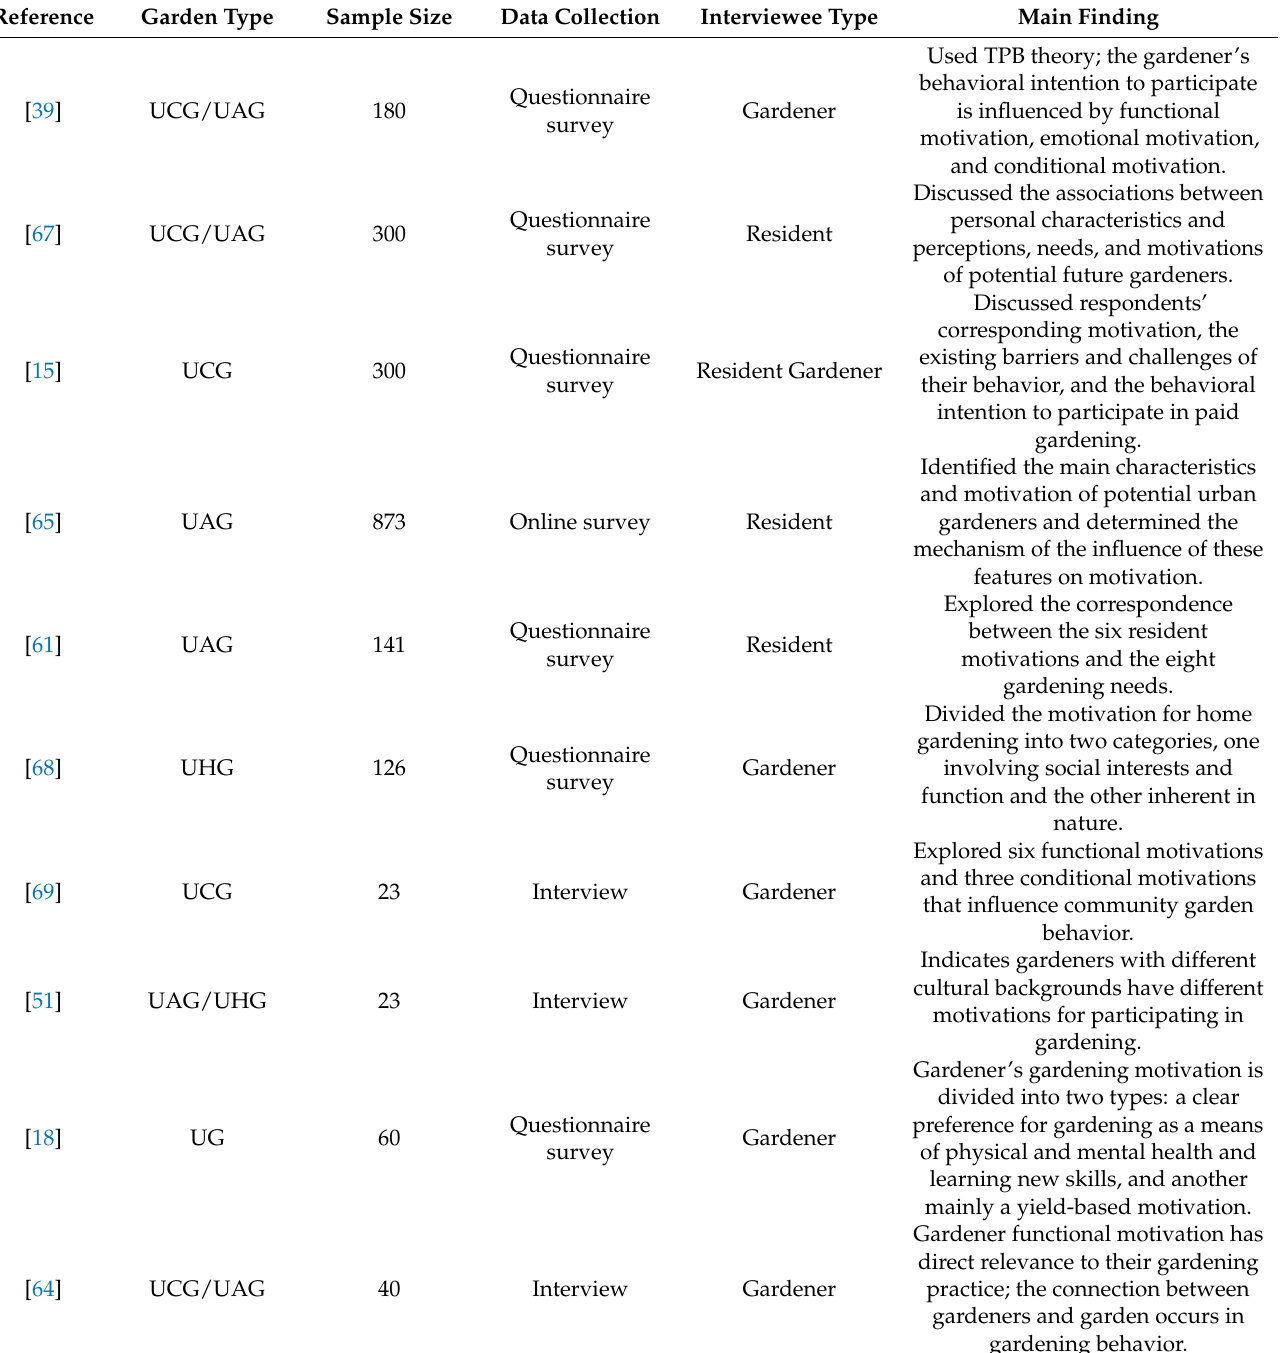
Table 1. Motivations related to urban gardening behavioral intention or behavior